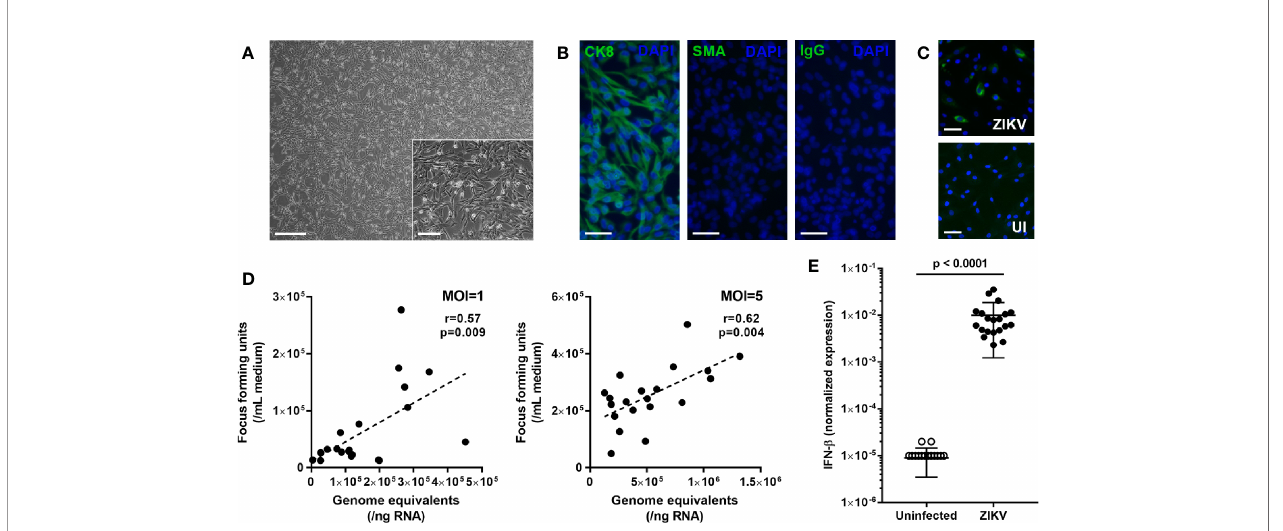
FIGURE 1 | (A) Light photomicrograph of human iris pigment epithelial cells immediately prior to infection. Original magni fi cations: 40x (main image) and 100x (inset image); Scale bars: 500 µm (main image) and 200 µm (inset image). (B) Fluorescence photomicrographs of human iris pigment epithelial cells immunolabeled to detect presence of cytokeratin 8 (CK8) and absence of alpha-smooth muscle actin (SMA), with negative control labeled with species-matched immunoglobulin (IgG). Alexa Fluor 488 (green) with DAPI nuclear counterstain (blue). Original magni fi cation: 200x; Scale bar: 100 µm. (C) Fluorescence photomicrographs of ZIKV-infected and uninfected human iris pigment epithelial cells immunolabeled to detect fl avivirus envelope protein. Alexa Fluor 488 (green) with Hoechst 33342 nuclear counterstain (blue). Original magni fi cation: 100x; Scale bar: 100 µm. (D) Correlation plots showing cellular viral load in genome equivalents and infectious foci generated from culture supernatant for human iris pigment epithelial cells infected for 24 hours with ZIKV (multiplicity of infection = 1 and 5). Circles represent individual cell isolates from 20 donors. Line indicates trend. Data were analyzed by Pearson correlation coef fi cient. (E) Graph presenting normalized expression of interferon (IFN)- b transcript, calculated relative to peptidylprolyl isomerase A (PPIA) and ribosomal protein lateral stalk subunit P0 (RPLP0), in human iris pigment epithelial cells infected for 24 hours with ZIKV (multiplicity of infection = 5). Circles represent individual cell isolates from 20 donors. Crossbars indicate mean, and error bars indicate standard deviation. Data were analyzed by Wilcoxon signed-rank